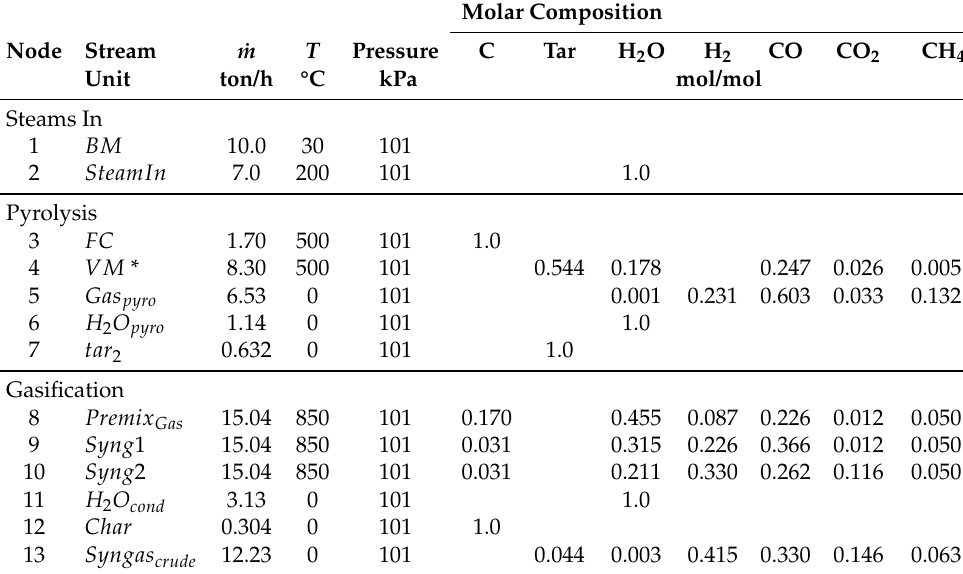
Table 6. Material balance and composition for the model KinetM at a temperature of 850 °C and S / B of 0.7. * The molar composition of VM corresponds to the products of the pyrolysis reaction after R